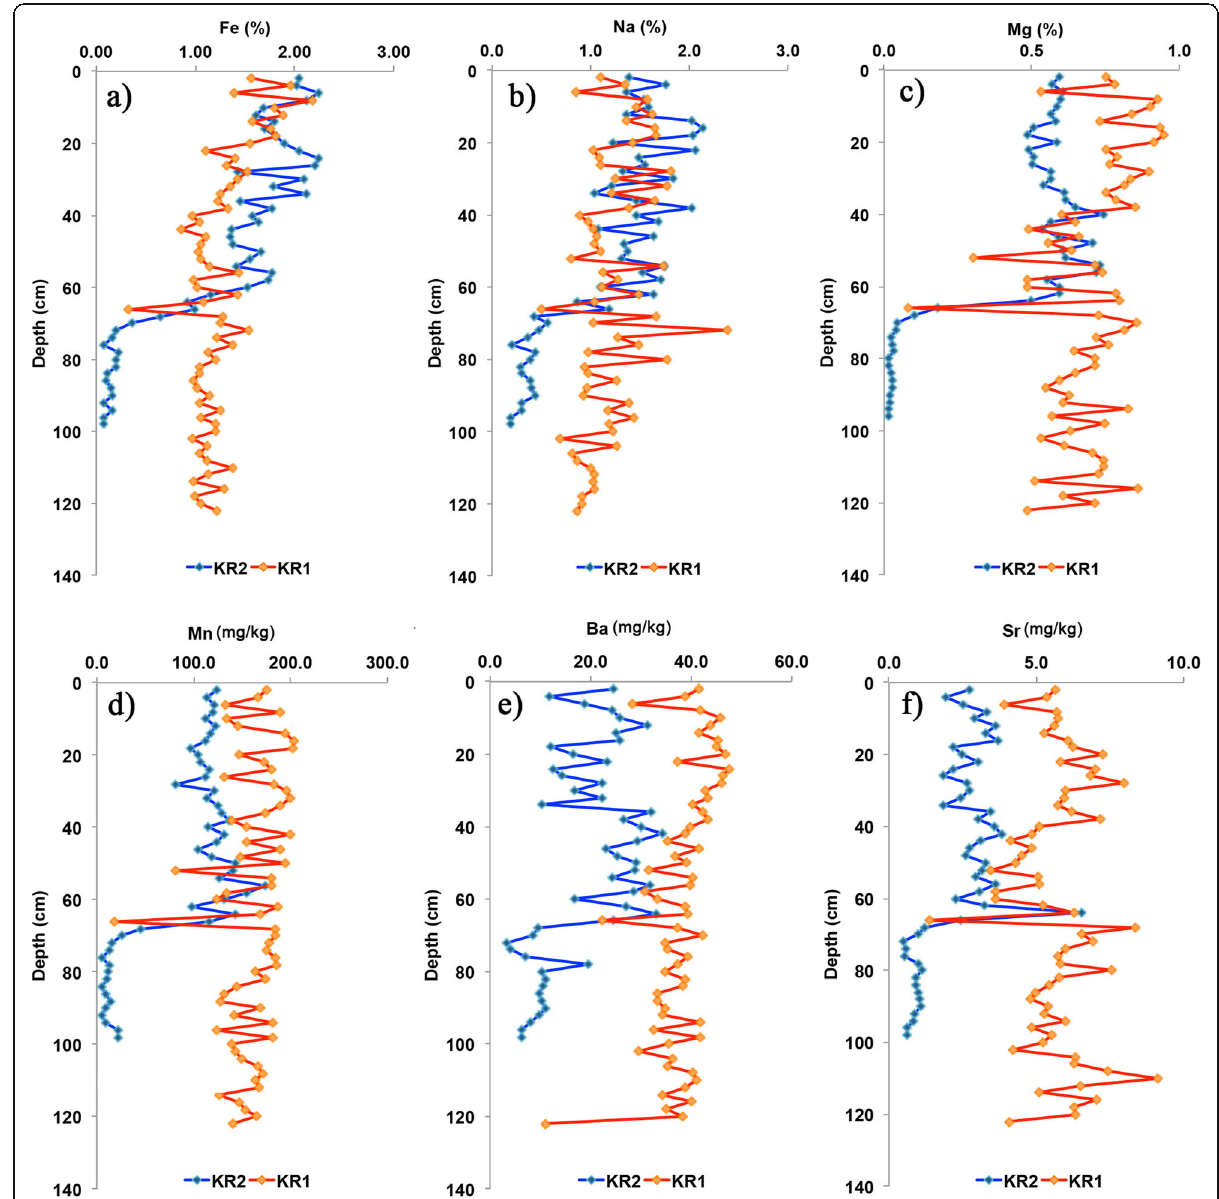
Fig. 4 Selected metals concentrations in cores KR1 and